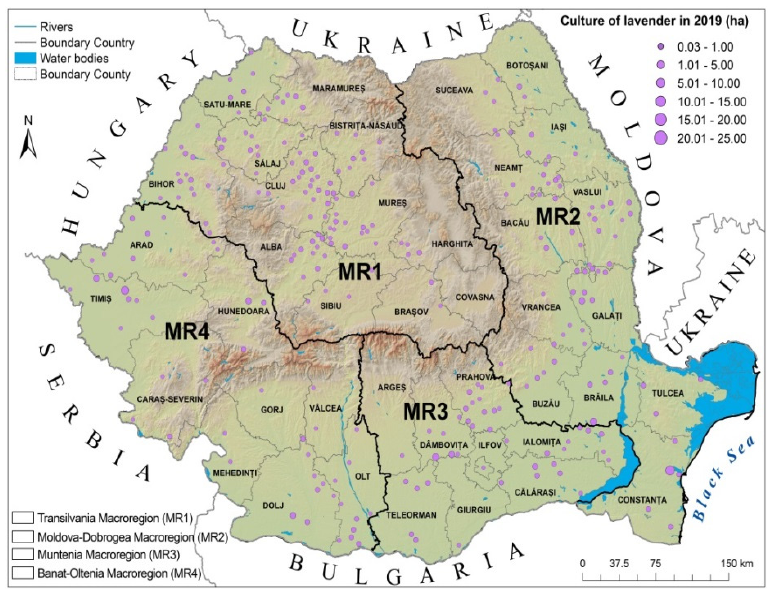
Figure 1. Areas covered with lavender farms per locality in Romania (2019). Source: APIA data, 2019.